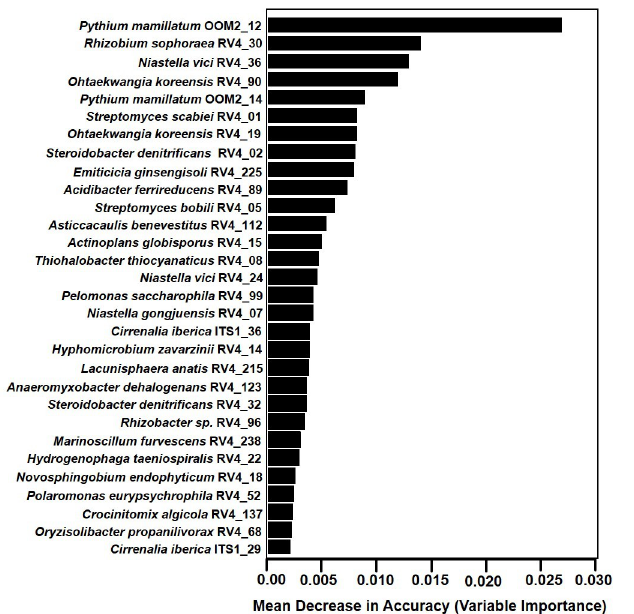
Fig 6. Top-30 ASVs selected as variables in the random forest (RF) classification model, plotted in order of importance. High values of the mean decrease in accuracy indicate more important variables in the RF classification. The taxa names are based on NCBI Blast hit, followed by the assigned ASV